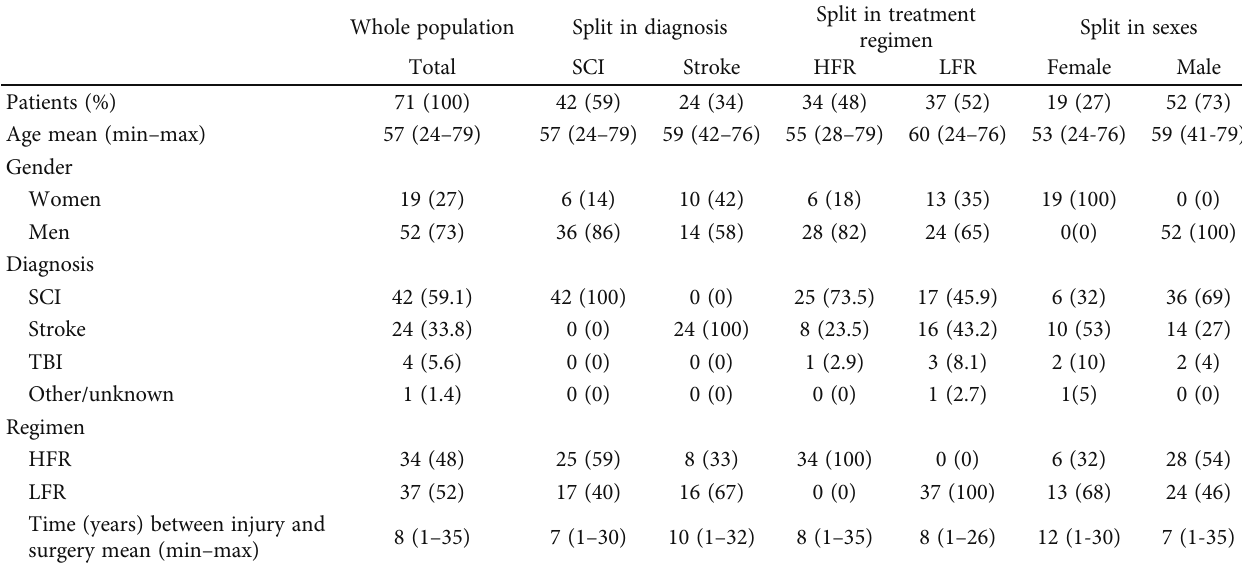
Figure 1: Study fl ow. ICF = International Classi fi cation of Functioning, Disability, and Health; COPM = Canadian Occupational Performance Measure. Table 1: Demographic and clinical characteristics of the study population as a whole and split in diagnosis, regimens, and